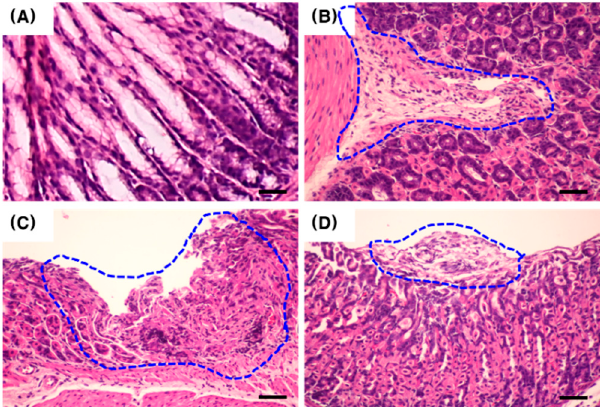
Figure 3. Histological analysis of hematoxylin and eosin-stained mouse gastric tissue after H. pylori SS-1 inoculation. H. pylori SS-1 was administered to C57BL/6 mice for 30 days. ( A ) uninfected control; ( B ) inflammatory cell infiltration (dotted line) in an H. pylori -infected mouse; ( C ) erosion (dotted line) in an H. pylori -infected mouse; ( D ) catarrhal inflammation (dotted line) in an H. pylori -infected mouse. Scale bar = 20 μ m.